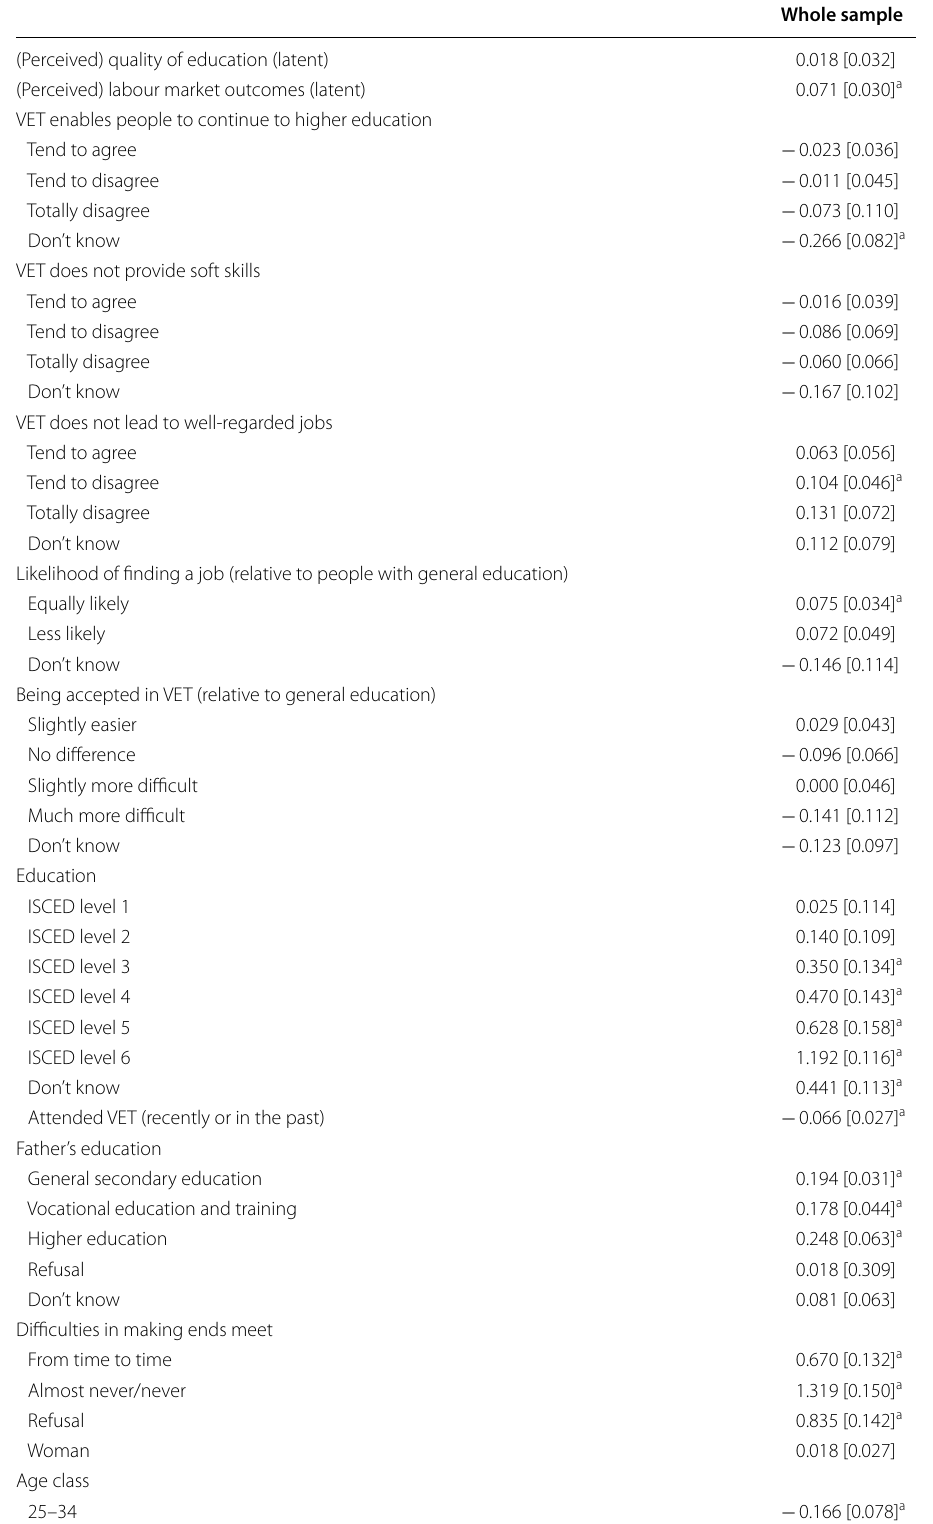
Table 8 The effect of VET on social positioning on the whole sample and by broad age group. Weighted data, OLS (clustered standard error in brackets)